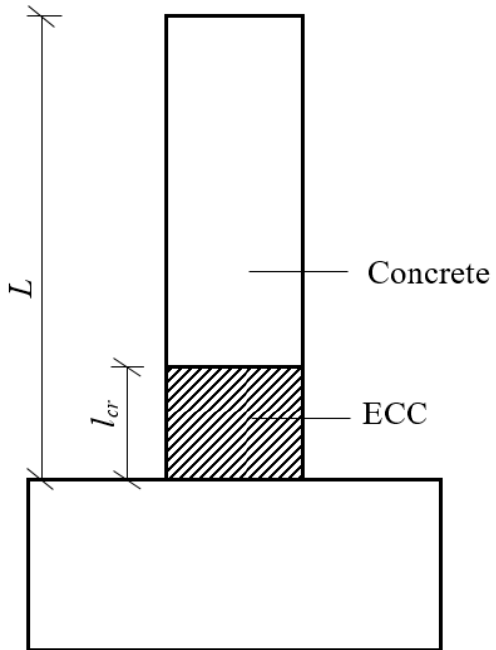
Figure 1. Schematic of ECC use area for concrete–ECC composite columns.